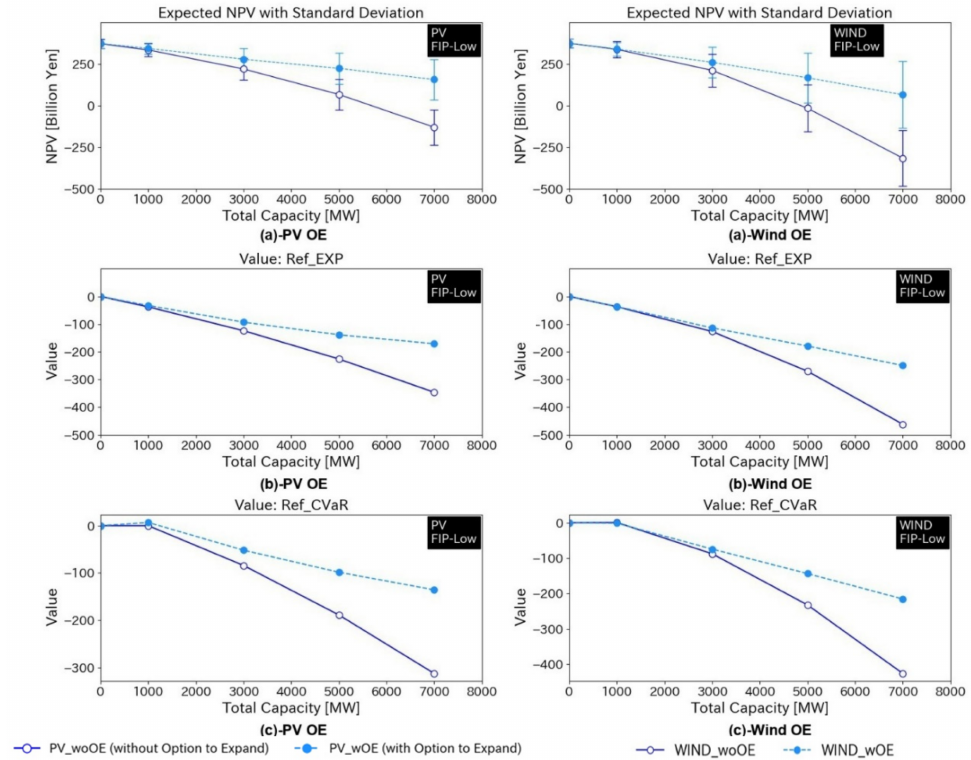
Figure 11. Results of option to expand in case of low FIP: ( a ) Expected NPV with standard deviation, ( b ) Value in case of high RFP and ( c ) Value in case of low